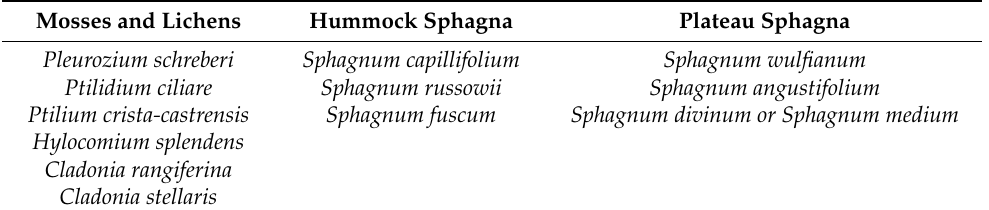
Table 2. Subdivision of bryophytes in three categories: mosses and lichens, hummock sphagna, and plateau